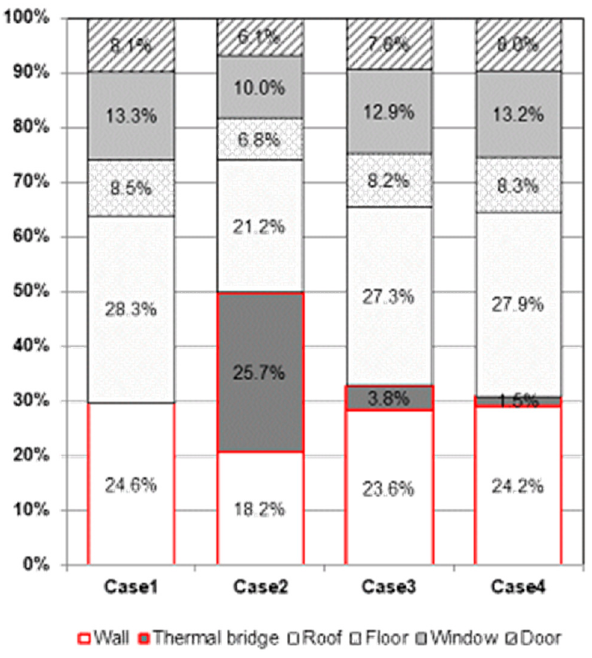
Figure 11. Percentage of heat lost through thermal bridges.